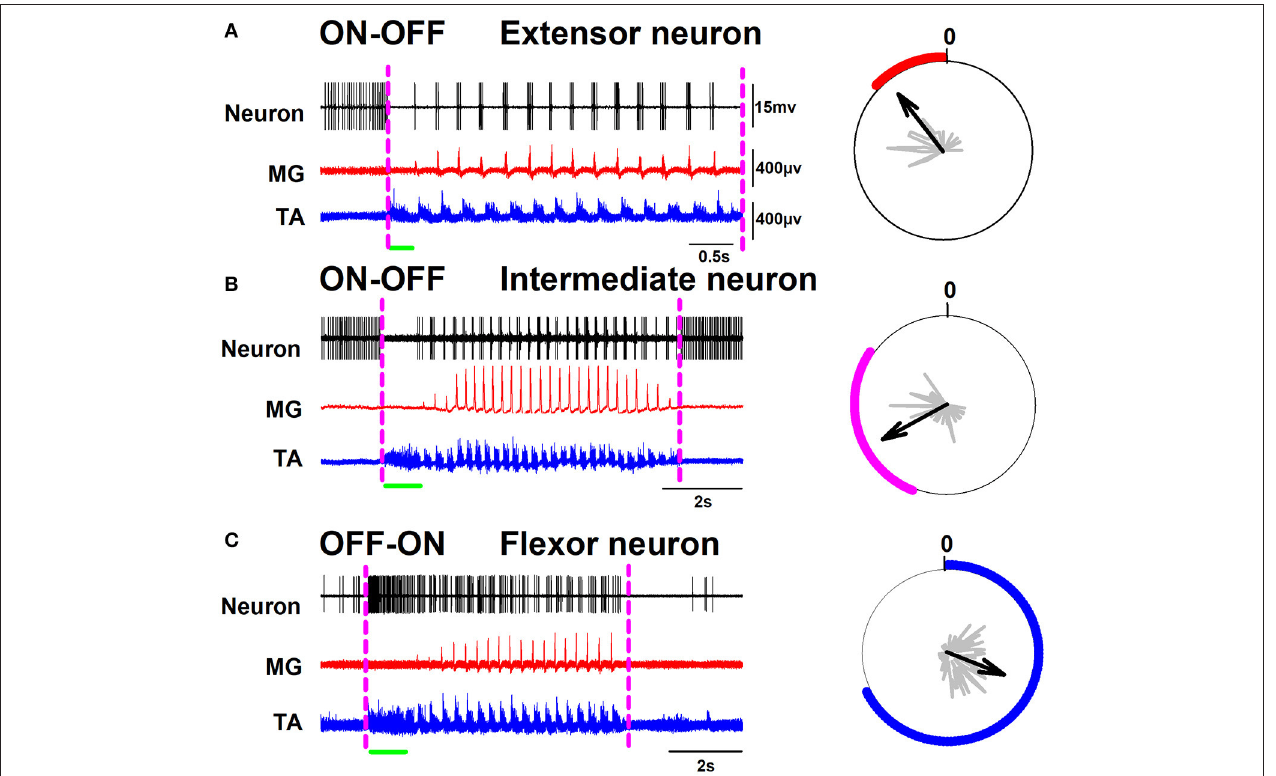
FIGURE 1 | Representative spinal neurons are exhibiting ON-OFF and OFF-ON firing activity during scratching. (A) Left panel, recordings of an extensor neuron and the electroneurograms of the medial gastrocnemius (MG) and tibial anterior (TA) nerves, Right panel, a polar plot of the neuronal firing activity. (B,C) the same as (A) but for an intermediate and a flexor neuron, respectively. The green horizontal line indicates the tonic flexor phase in the electrical activity of the TA